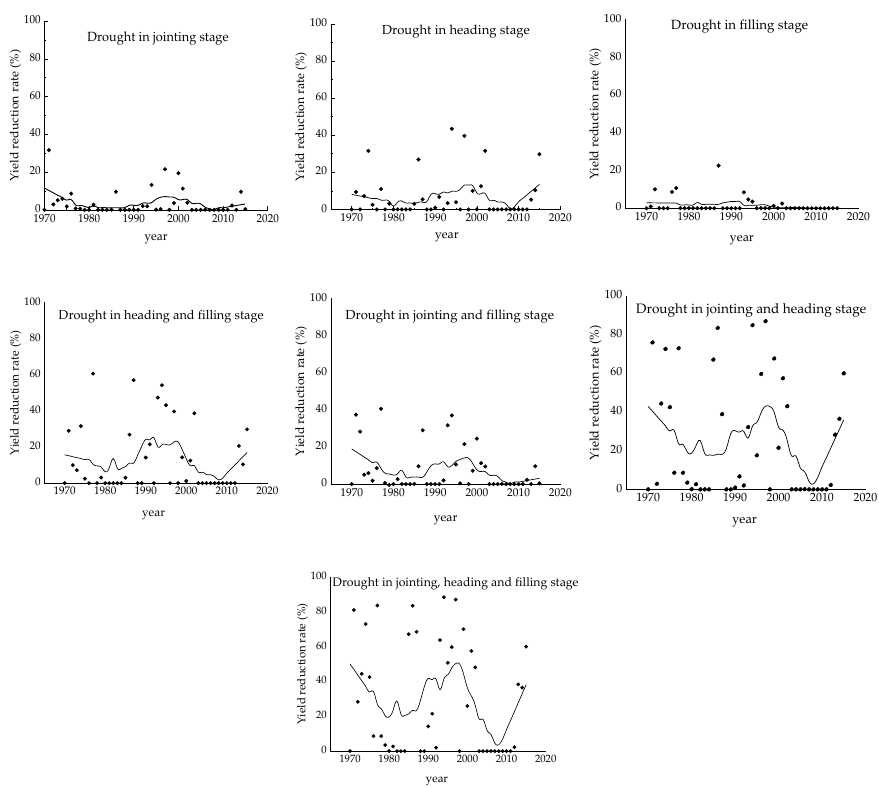
Figure 8. Simulated temporal variation in summer maize yield reduction from 1970 to 2015.